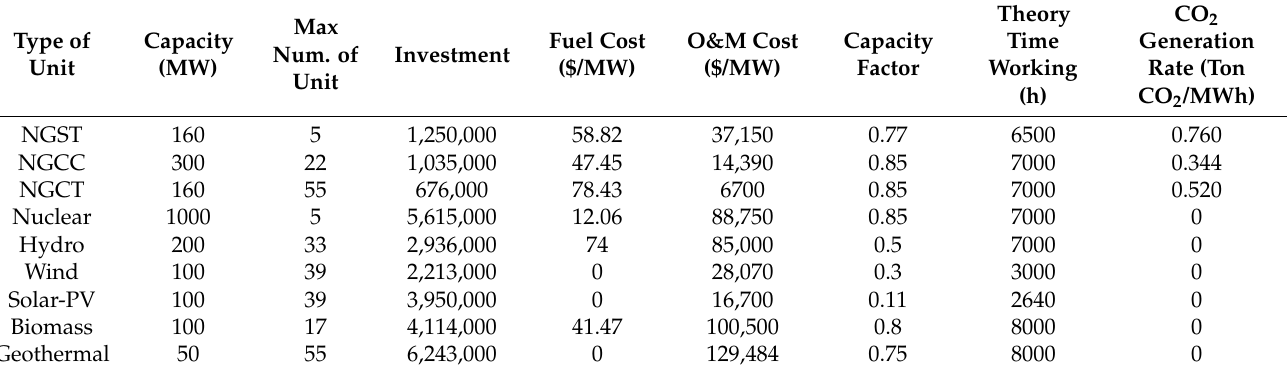
Table 2. Information of current generation units in Iranian power systems